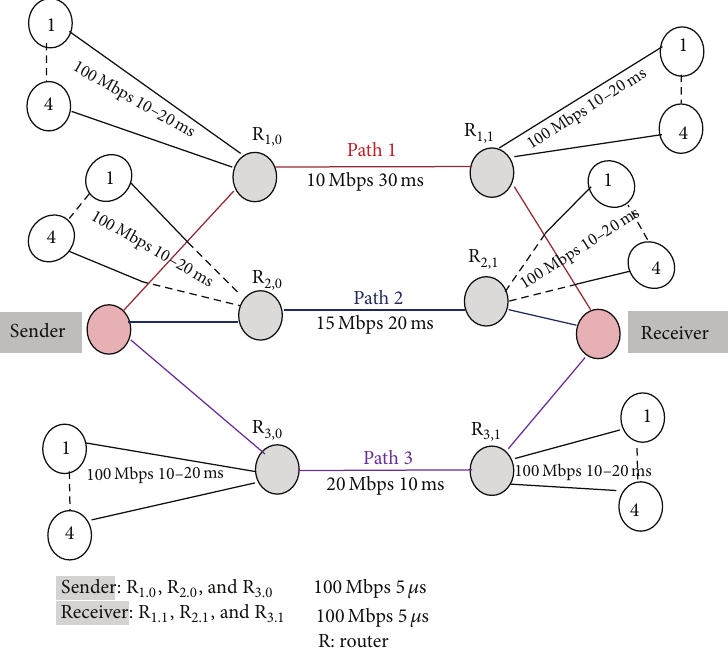
Figure 5: Simulation topology for asymmetric paths.